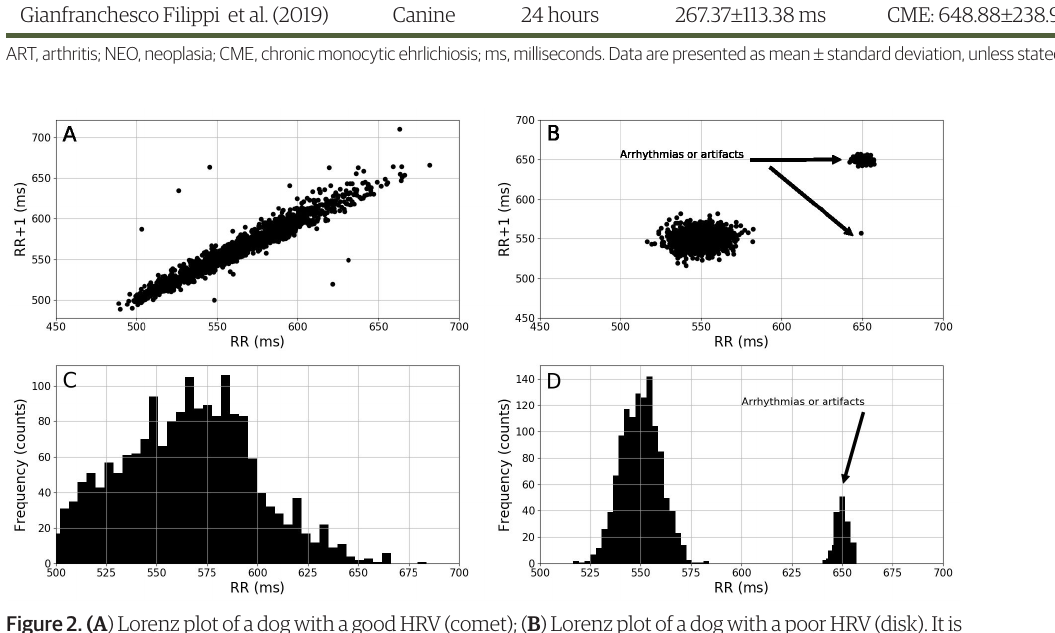
Figure 2. (A ) Lorenz plot of a dog with a good HRV (comet); ( B ) Lorenz plot of a dog with a poor HRV (disk). It is also possible to observe that artifacts or arrhythmias are clustered in a different region of the graph, making it possible to identify these events; ( C ) Density histogram of the same dog as seen in A; ( D ) Density histogram of the same dog as seen in B, where it is possible to observe that arrhythmias or artifacts present different modal